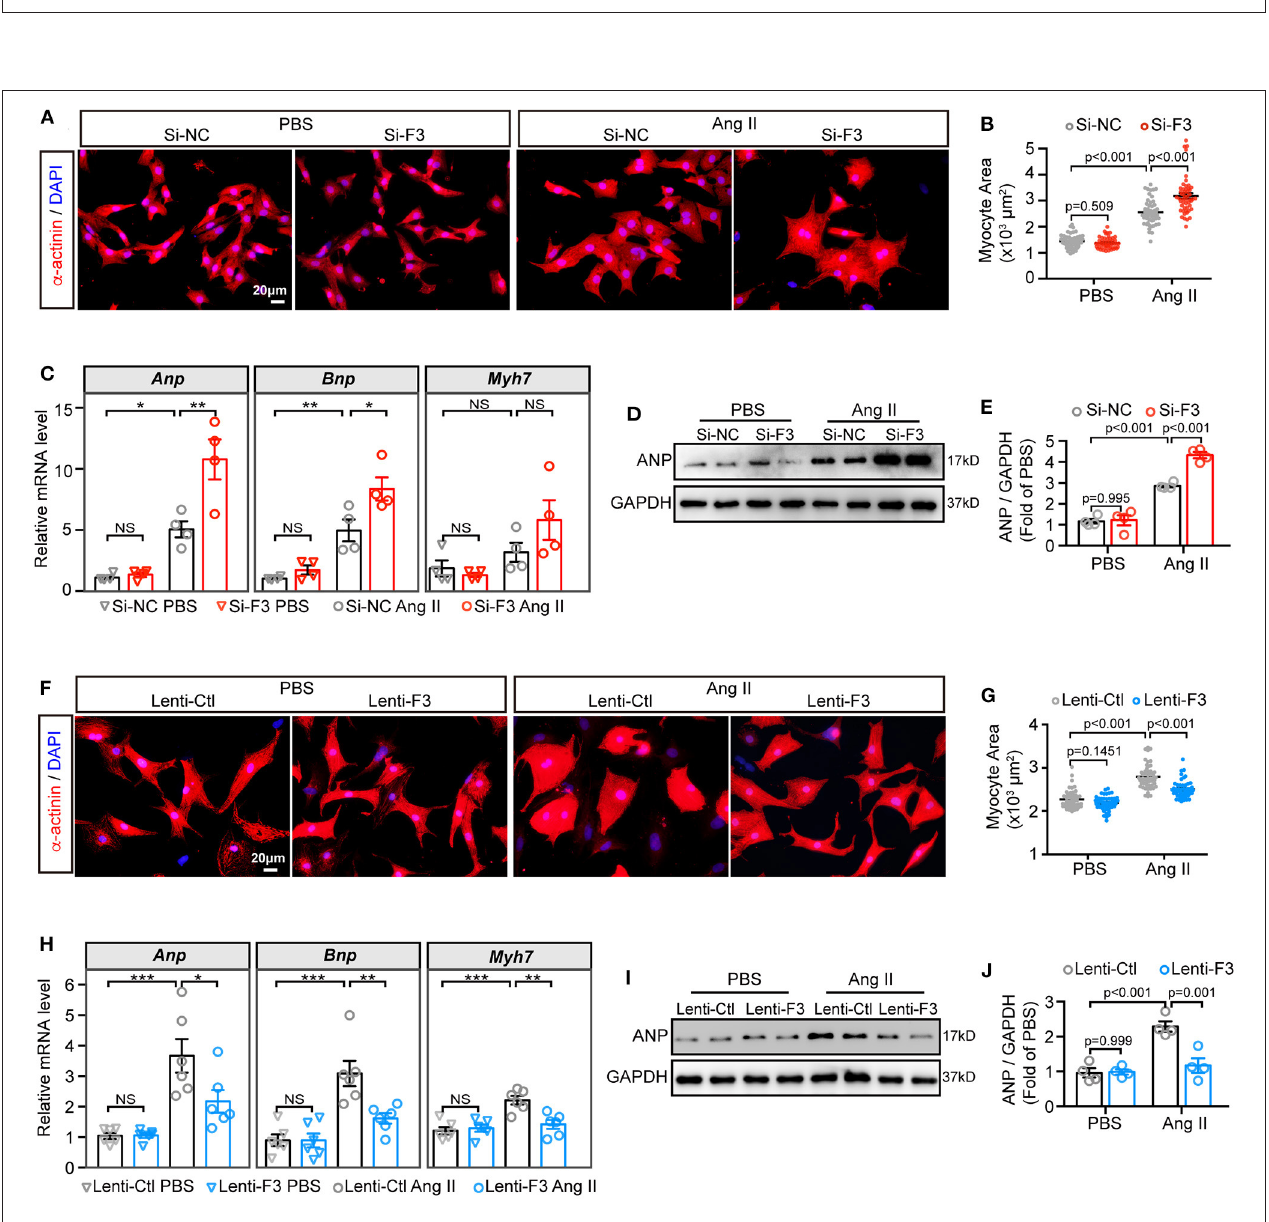
FIGURE 2 | in (A) . (D) The ratio of heart weight to body weight from sham or TAC-operated WT or F3-KO mice. (E) Images of H&E stained longitudinal sections of the indicated hearts. (F) Heart sections stained with WGA to compare the size of the cardiomyocyte area. (G) Quantification results in (F) ; a total of 100 cells/group were calculated. (H) qPCR assays compared the mRNA expression of Anp , Bnp , Acta1 , and Myh7 at 4 weeks after sham or TAC operation. NS, not significant, * p < 0.05, ** p < 0.01, *** p < 0.001. (I) Representative western blot images of ANP in the indicated groups. (J) Quantification results of (I) . [ B–D , n = 8, 8, 15, 15, respectively; H , n = 6; J , n = 4; (B–D,G,H,J) Tukey’s post-hoc test].